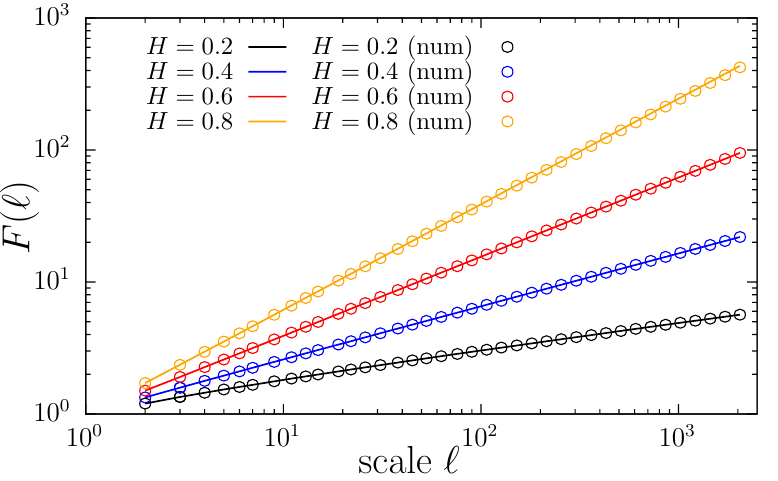
Figure 4. FA functions F ( (cid:96) ) obtained for 1/ f β noises using different input Hurst exponents H = 2 β 1. The solid lines are obtained by plotting the analytical result (20), while the symbols − correspond to the numerical results obtained by applying (18) to 1/ f β noises with N = 2 20 generated using